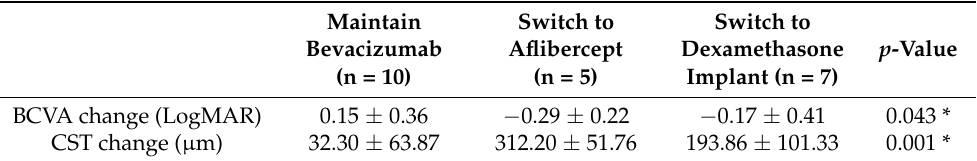
Table 2. Comparison of further treatment responsiveness in diabetic macular edema patients with moderate to severe